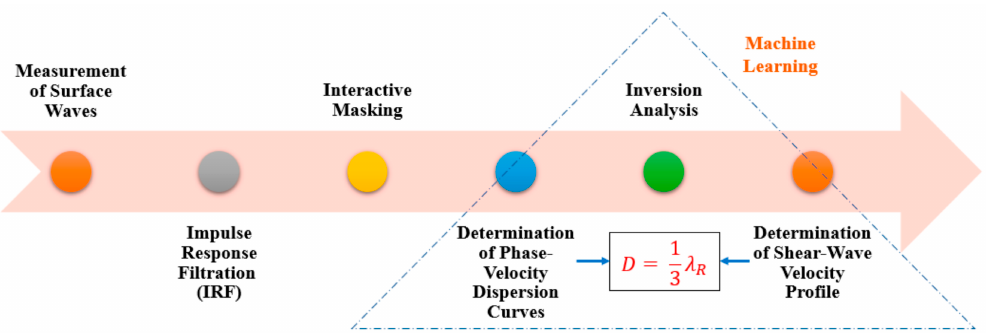
Figure 10. Implementation of ML in the SASW inversion method.